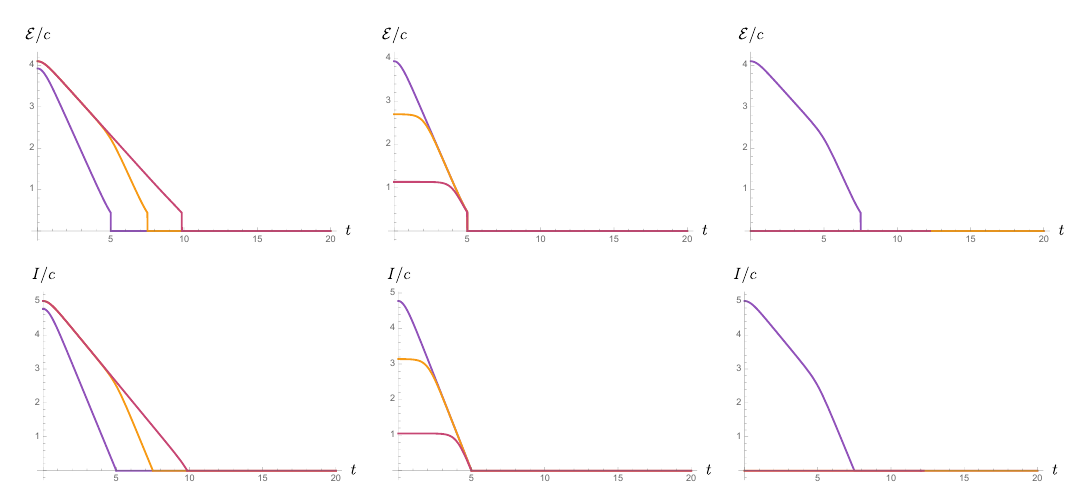
Figure 9 . The large-c OLN (3.34) is plotted in the top row and the OMI (3.28) in the bottom